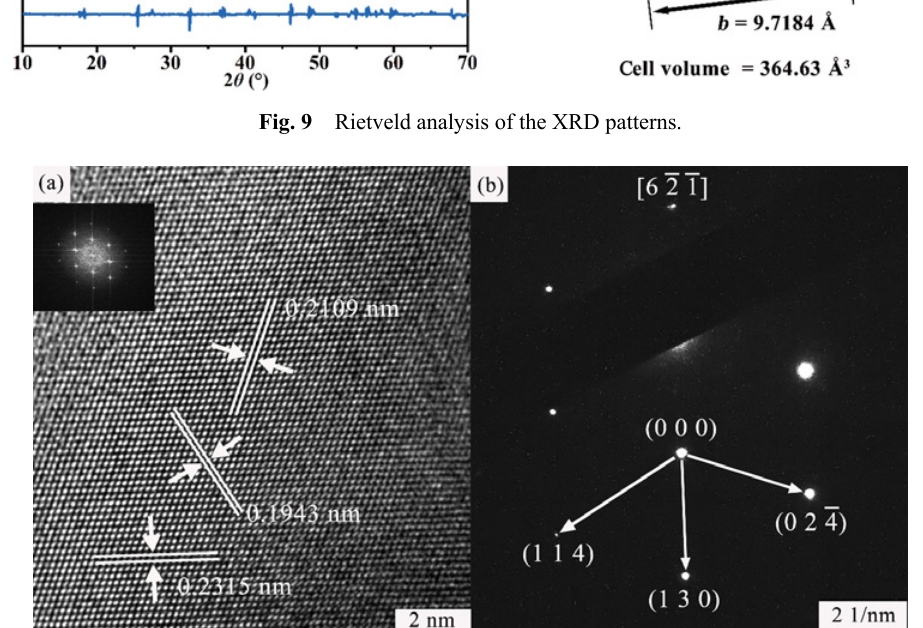
Fig. 10 (a) HRTEM image of high-entropy (Mg,Co,Ni,Zn)Ti 2 O 5 and (b) corresponding SAED